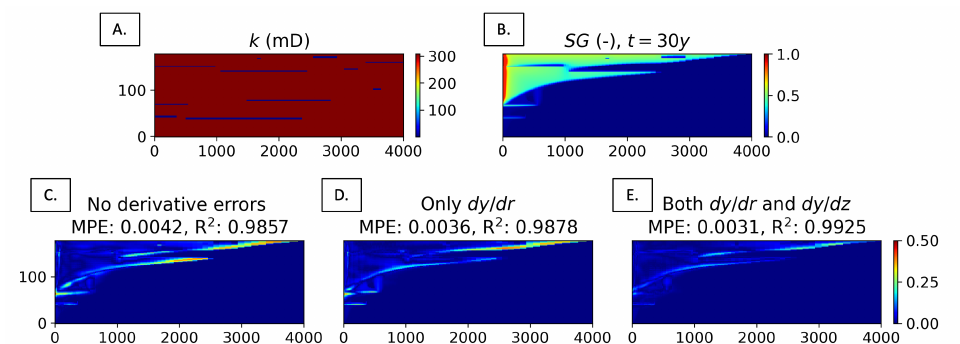
Figure 3. Comparison of the gas saturation model performance depending on the incorporation of r - and z -errors in the training loss function. ( A ) Permeability field of an example reservoir. ( B ) Actual gas saturation data from numerical simulation. ( C – E ) Absolute error of predictions from models trained with different loss functions.